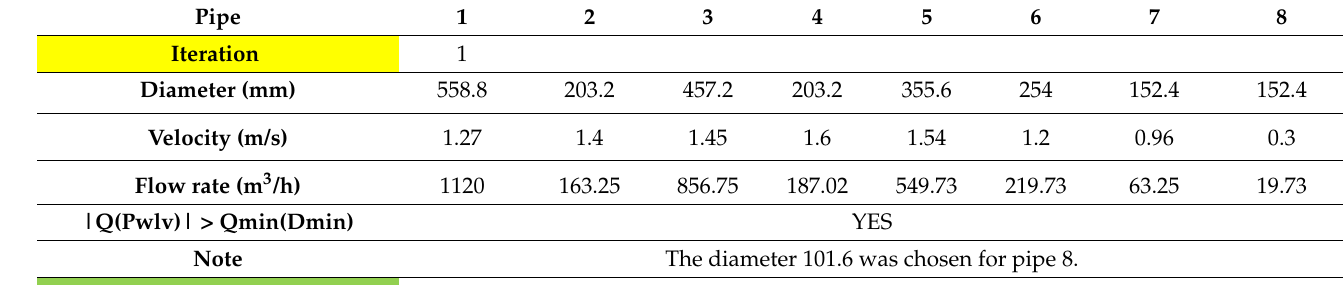
Table 1. Application example of Process